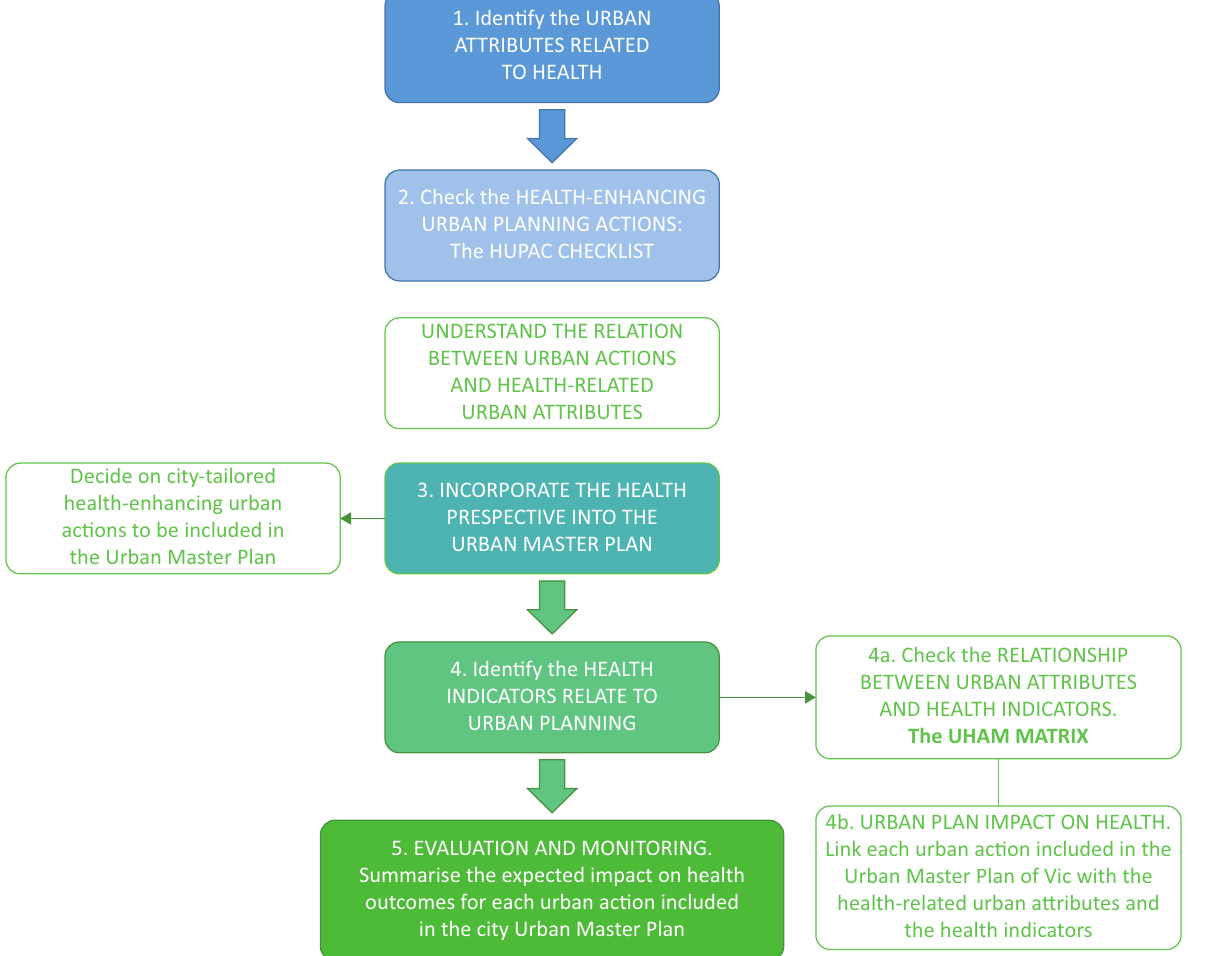
Figure 6. Comprehensive approach to connect the urban planning actions of the Vic urban master plan with the health‐ related urban attributes and citizens’